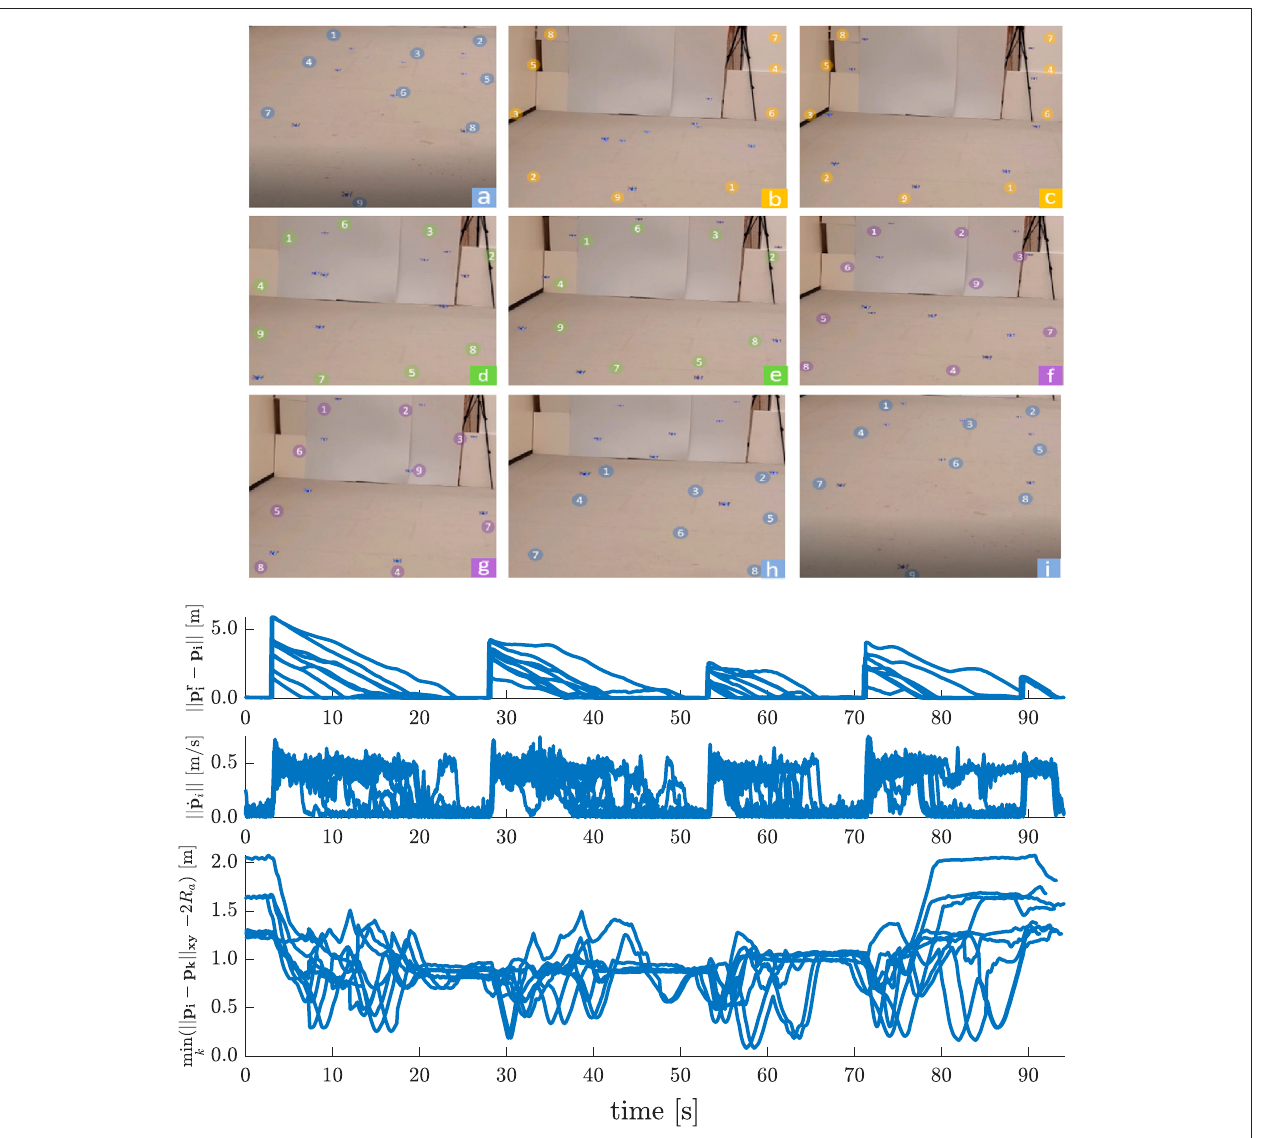
FIGURE 13 | 3D Point-to-Point Transitions with Agent Collision Avoidance − Asymptotically stable, collision free consecutive formations of the initials of the University of Colorado Boulder (UCB) are made. Nine consecutive shots (a – i) show the swarm members safely navigating from an initial con fi guration (in blue, shot a),totheUcon fi guration(inyellow,shotc),totheCcon fi guration(ingreen,shote),totheBcon fi guration(inpurple,shotg),and fi nallybacktotheinitialcon fi guration (in blue, shot